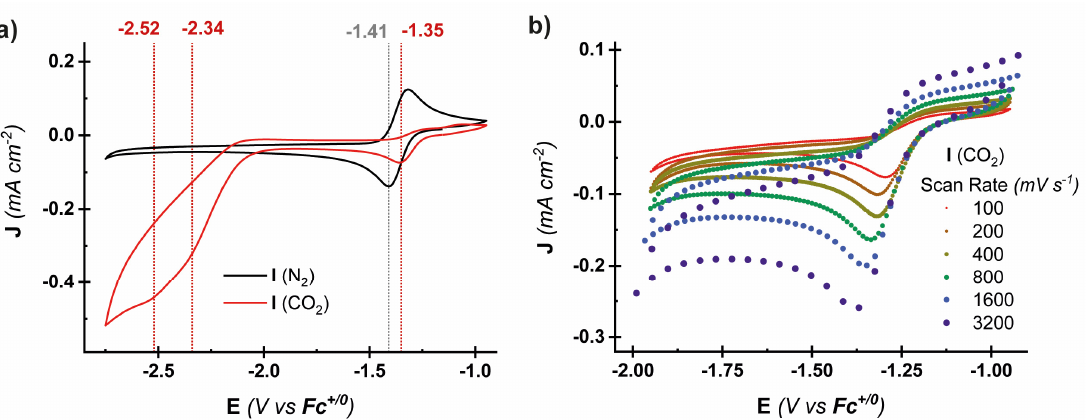
Figure 3. CVs of complex I under N 2 (black line) and CO 2 (red line) recorded at 100 mV s − 1 ( a ) and under CO 2 at different scan rates (100–3200 mV s − 1 ) ( b ).